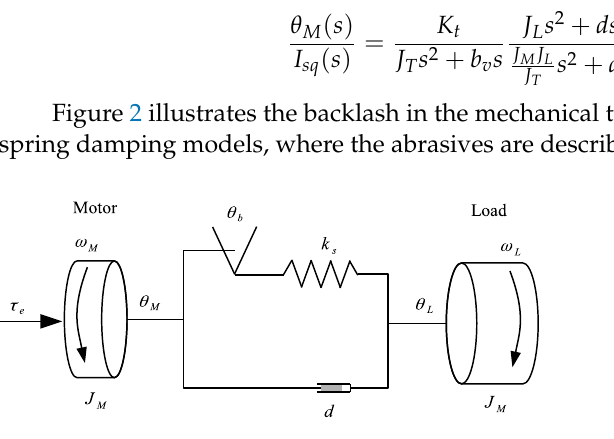
Figure 2. Illustration of the mechanical backlash model for two rotary masses. Table 1. Table of